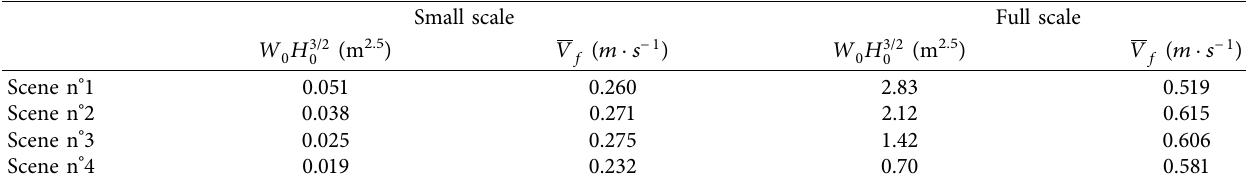
Table 6: Extrapolation of small-scale velocities into full-scale